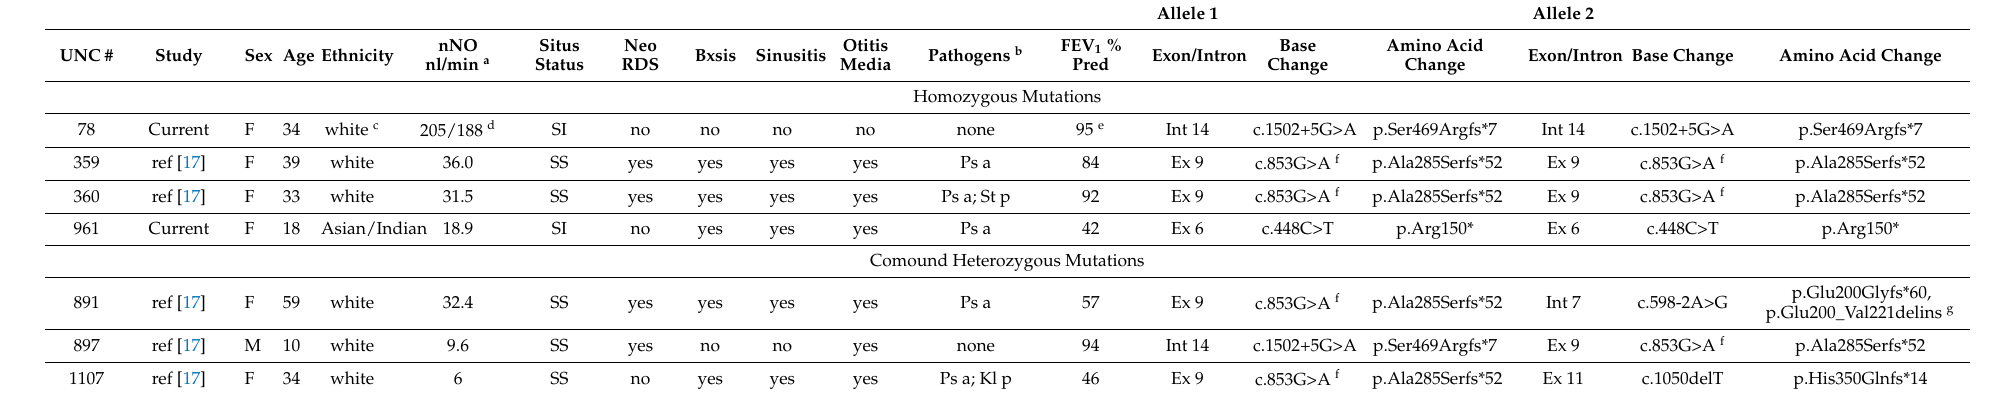
Table 1. Demographic, Clinical, and ODAD1 Mutations in PCD-Affected